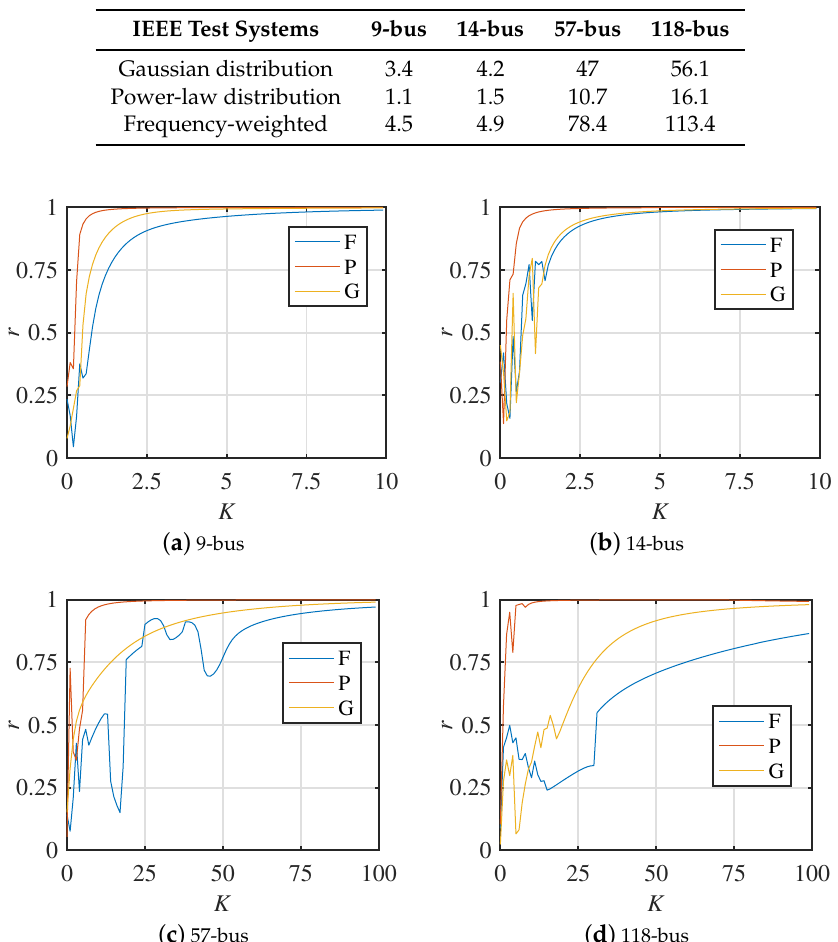
Figure 25. Synchronization progress of different weighting methods in the dynamic IEEE test